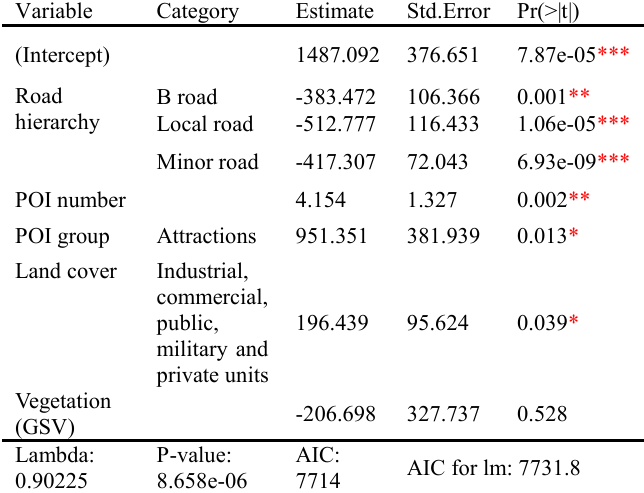
Table 5 . Spatial error model results (P-value<0.001***)